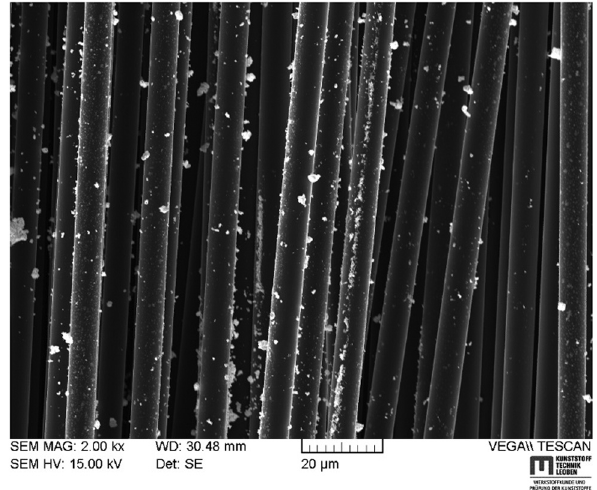
Figure 14: Ag - modi fi ed carbon fi bers using 6 V and 1